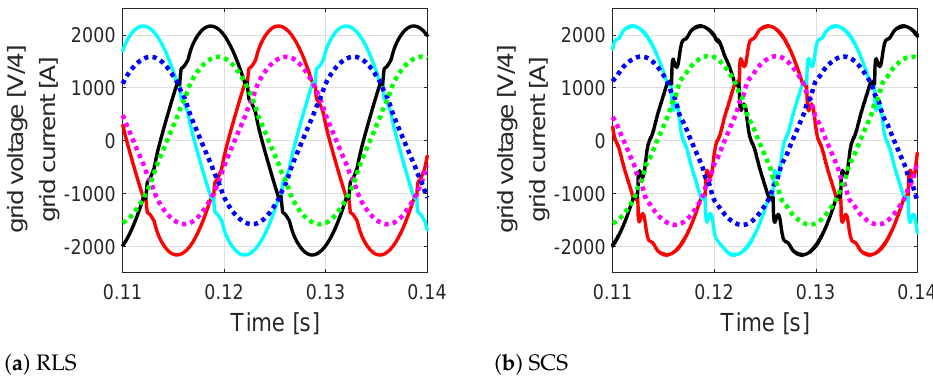
Figure 9. Waveforms of V PCC (continuous line-x0.25) and I PCC (dashed line) for ( a ) RLS and ( b ) SCS.